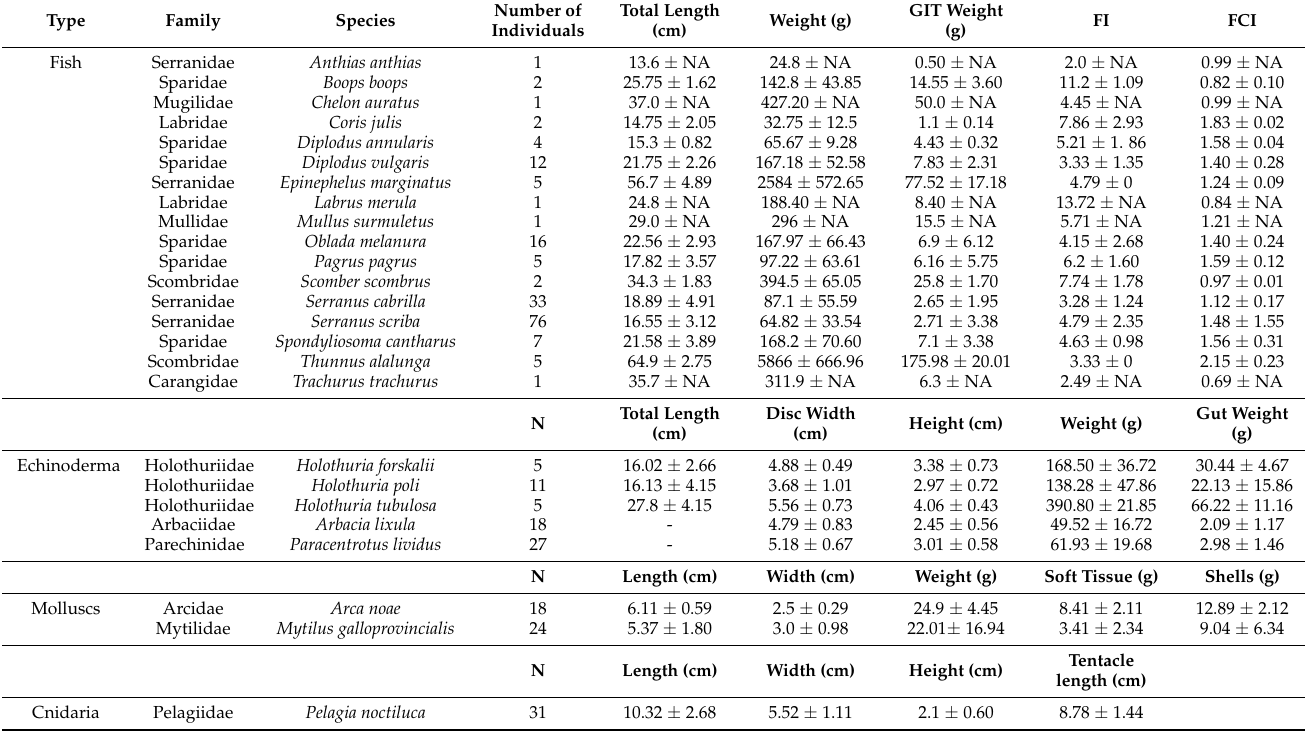
Table 1. Summary of biometric parameters for all species surveyed during the 2019 and 2020 scientific surveys in Cabrera MPA, according to: group of species (fish, echinoderma, mollusc and cnidaria), family, species, number of individuals (N), total length (cm), weight (g), gastrointestinal tract (GIT) weight (g), Fullness Index, Fulton’s Condition Factor, disc width (cm), height (cm), weight (g), soft tissue (g), shells (g), height (g), and tentacle length (cm). For those species with one individual, the standard deviation was not available